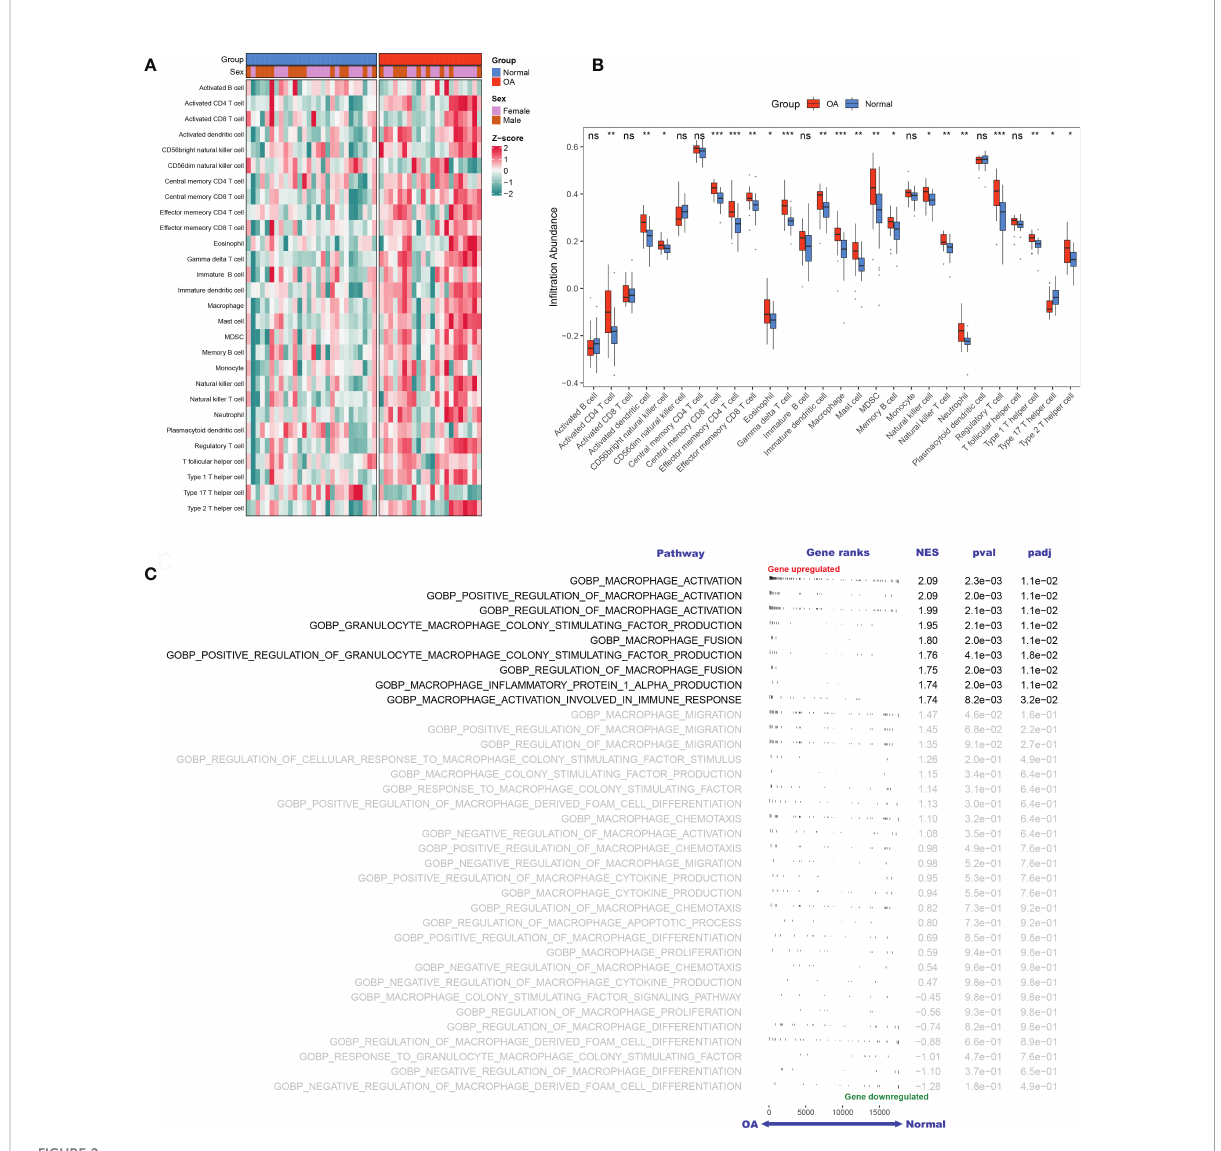
FIGURE 2 The landscape of immune in fi ltration and aberrant signaling pathways. A-B. Heatmap (A) and comparison boxplot (B) of 28-immune-cell in fi ltration between OA and control groups. ns, (not signi fi cant) P > 0.05; *P < 0.05, **P < 0.01, ***P < 0.001. (C) . GSEA analysis of 35 macrophage-associated biological pathways between OAs and controls. NES, normalized enrichment